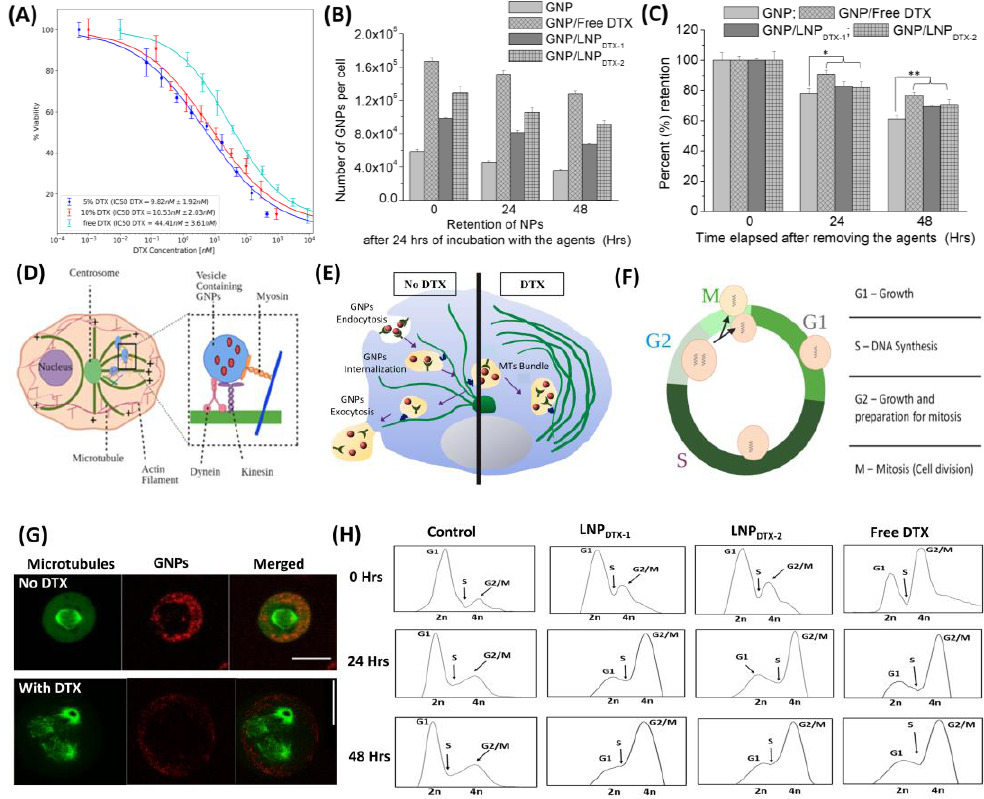
Figure 2. Effect of free docetaxel (DTX) vs. LNP DTX-P on MIA PaCa-2 cells in vitro. ( A ) IC-50 curves of free DTX, 5% DTX (LNP DTX-1 ), and 10% DTX (LNP DTX-2 ). ( B ) Amounts of gold nanoparticles (GNPs) per cell in control cells, cells treated with free DTX, cells treated with LNP DTX-1 , and cells treated with LNP DTX-2 over time. ( C ) GNP retention over time for control cells, cells treated with free DTX, cells treated with LNP DTX-1 , and cells treated with LNP DTX-2 . * indicates p < 0.05, ** indicates p < 0.01. ( D ) Visual illustration of GNP movement within a cell’s MTs [19]. ( E ) Schematic diagram illustrating the path of GNPs (red dots) within a cell in the absence and presence of DTX. ( F ) Cell cycle phases. In preparation for cell division, the cell goes through three different phases: a G1 gap phase between the M and S phases, an S phase where DNA replication occurs, and G2 where the cell prepares for mitosis. ( G ) Confocal images of dividing cancer cells: control (top) and DTX (bottom). GNPs are shown in red, and microtubules are shown in green. The scale bar: 25 µ m. ( H ) Cell cycle assay for control cells, cells treated with free DTX, cells treated with LNP DTX-1 , and cells treated with LNP DTX-2 over